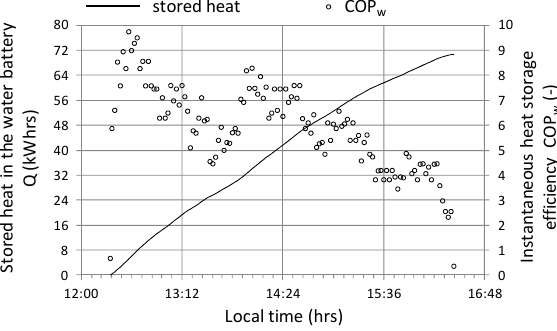
Figure 22. The course of changes in the efficiency of heat storage and the amount of heat stored in cycle No. 2.